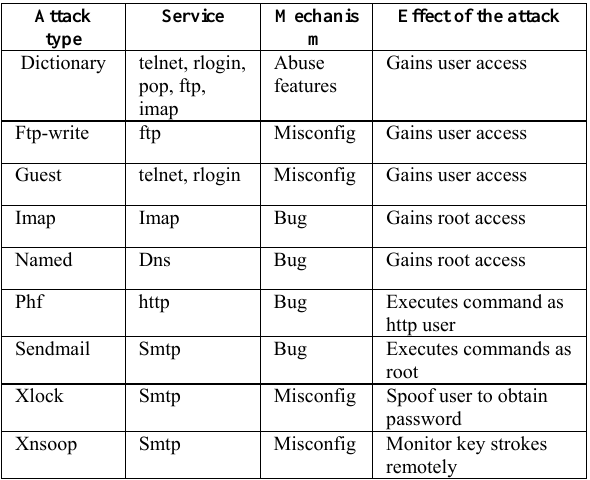
Table 2. Remote to user attack